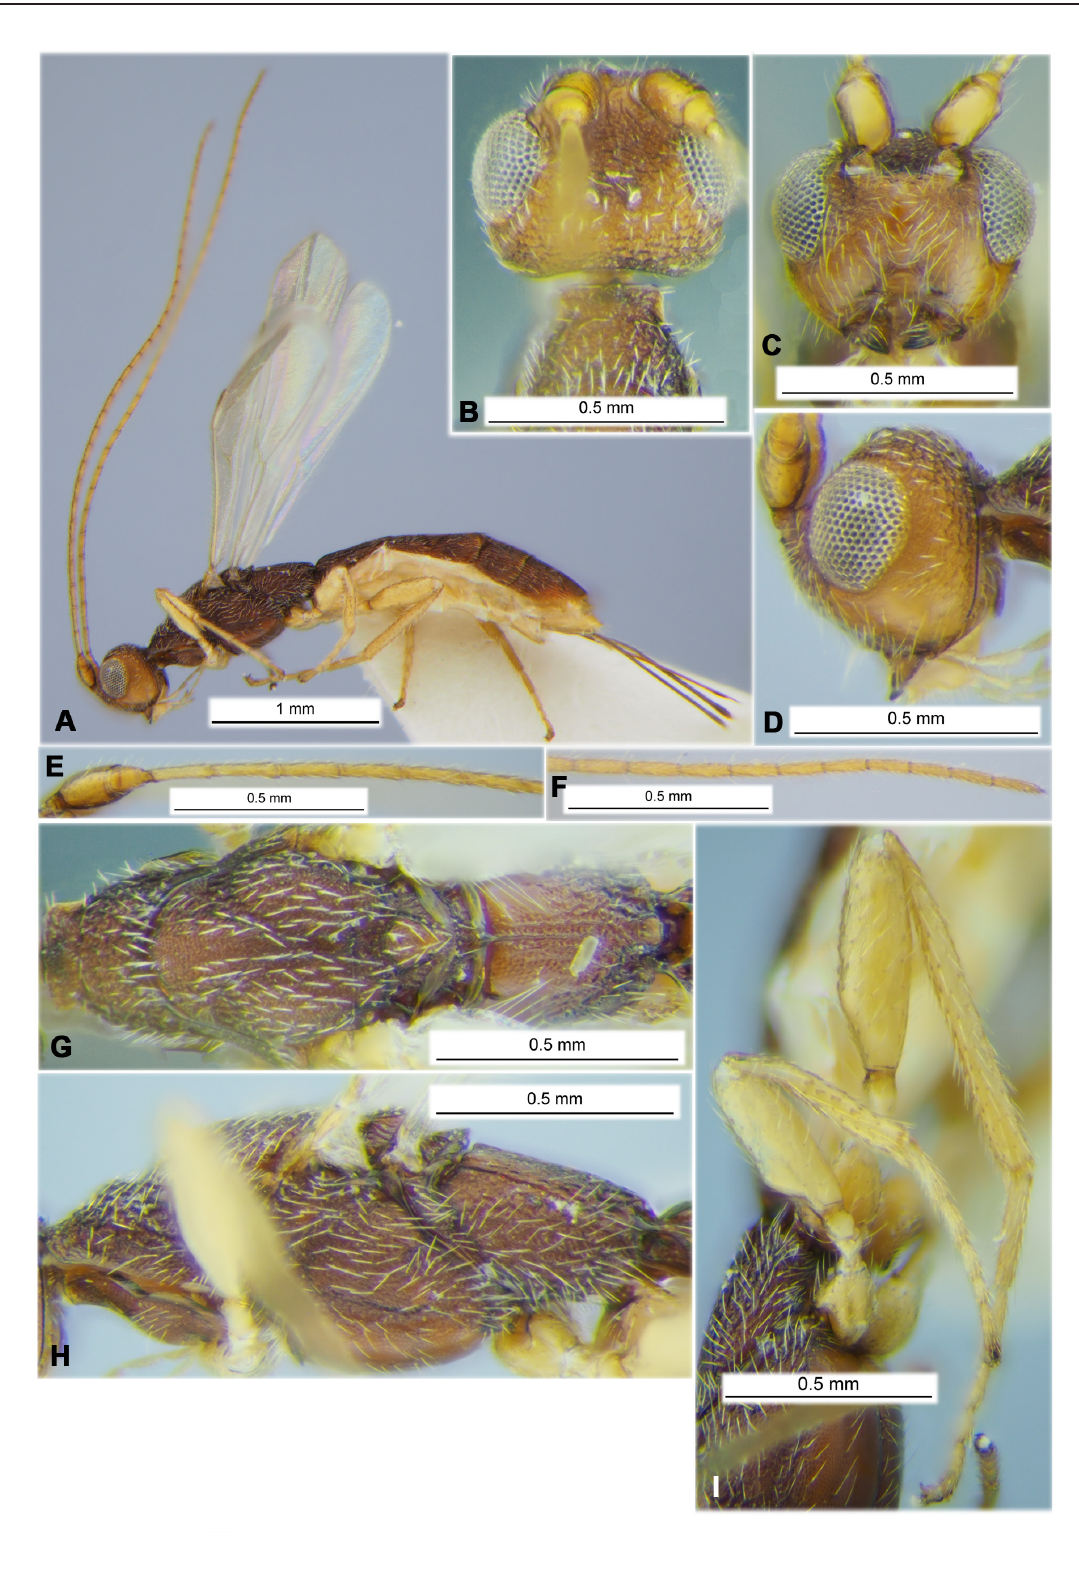
Fig. 51. Rhaconotus ( Rh. ) magniareolus Belokobylskij sp. nov., holotype, ♀ (RMNH). A . Habitus, lateral view. B . Head, dorsal view. C . Head, front view. D . Head, lateral view. E . Basal segments of antenna. F . Apical segments of antenna. G . Mesosoma, dorsal view. H . Mesosoma, lateral view. I . Hind